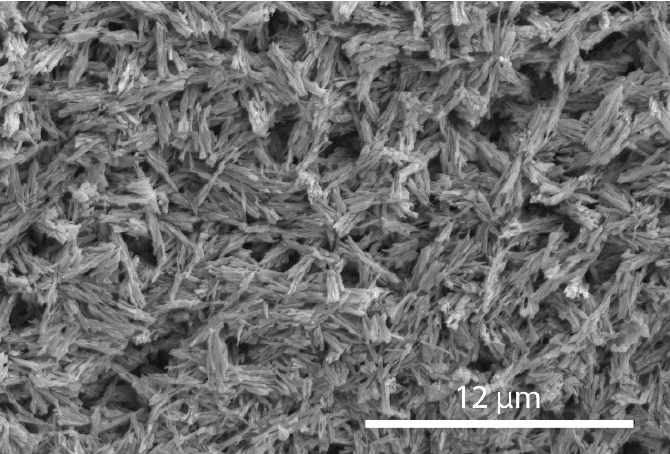
Figure 2. The transverse section of aragonitic irregularly oriented prismatic (AIOP) structure in Apomatus globifer .